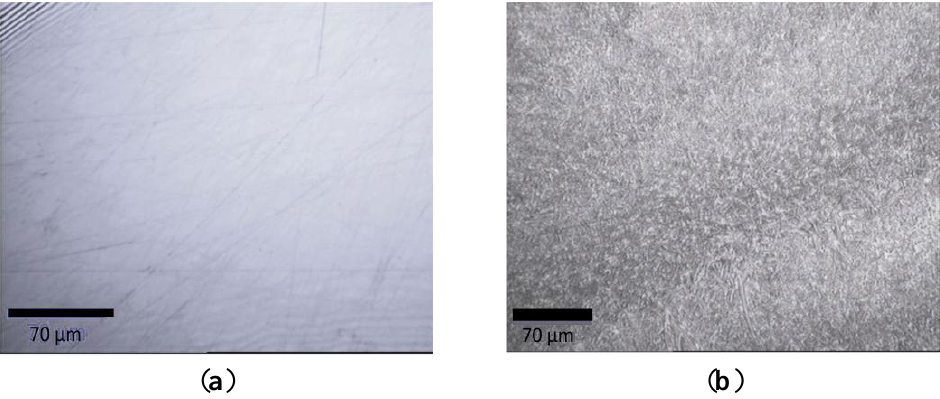
Figure 8. Microscopic images for: ( a ) PEI (5 mg/mL)/GCE and ( b ) PEI (5 mg/mL) + CD